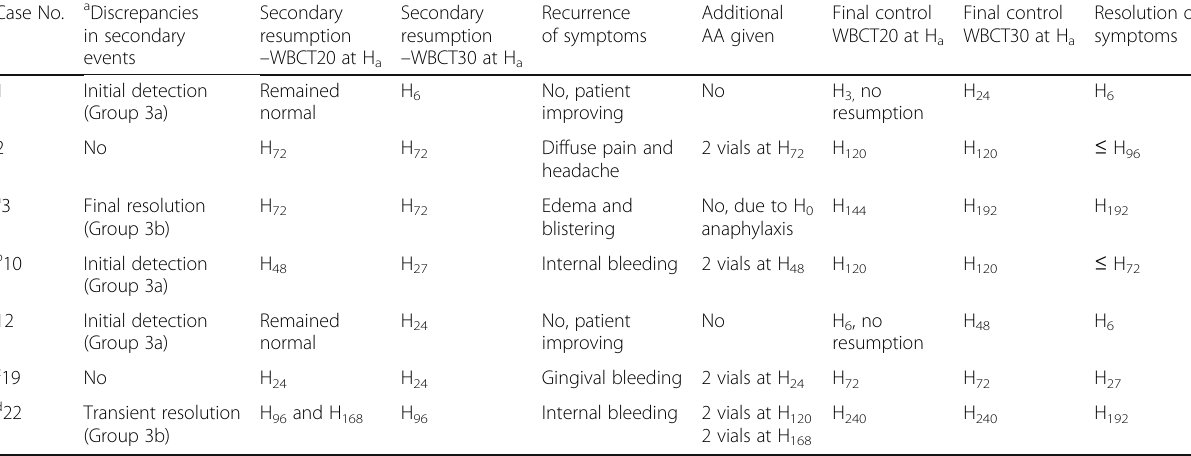
Table 5 Resumption and resolution of coagulopathy by WBCT20 and WBCT30 in seven patients with Echis envenomations Case No. a Discrepancies in secondary